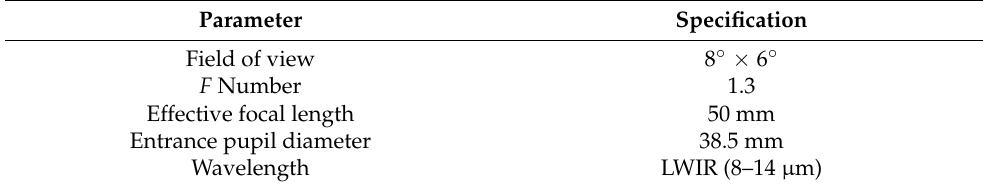
Table 1. Parameters of the nonsymmetric freeform imaging system.